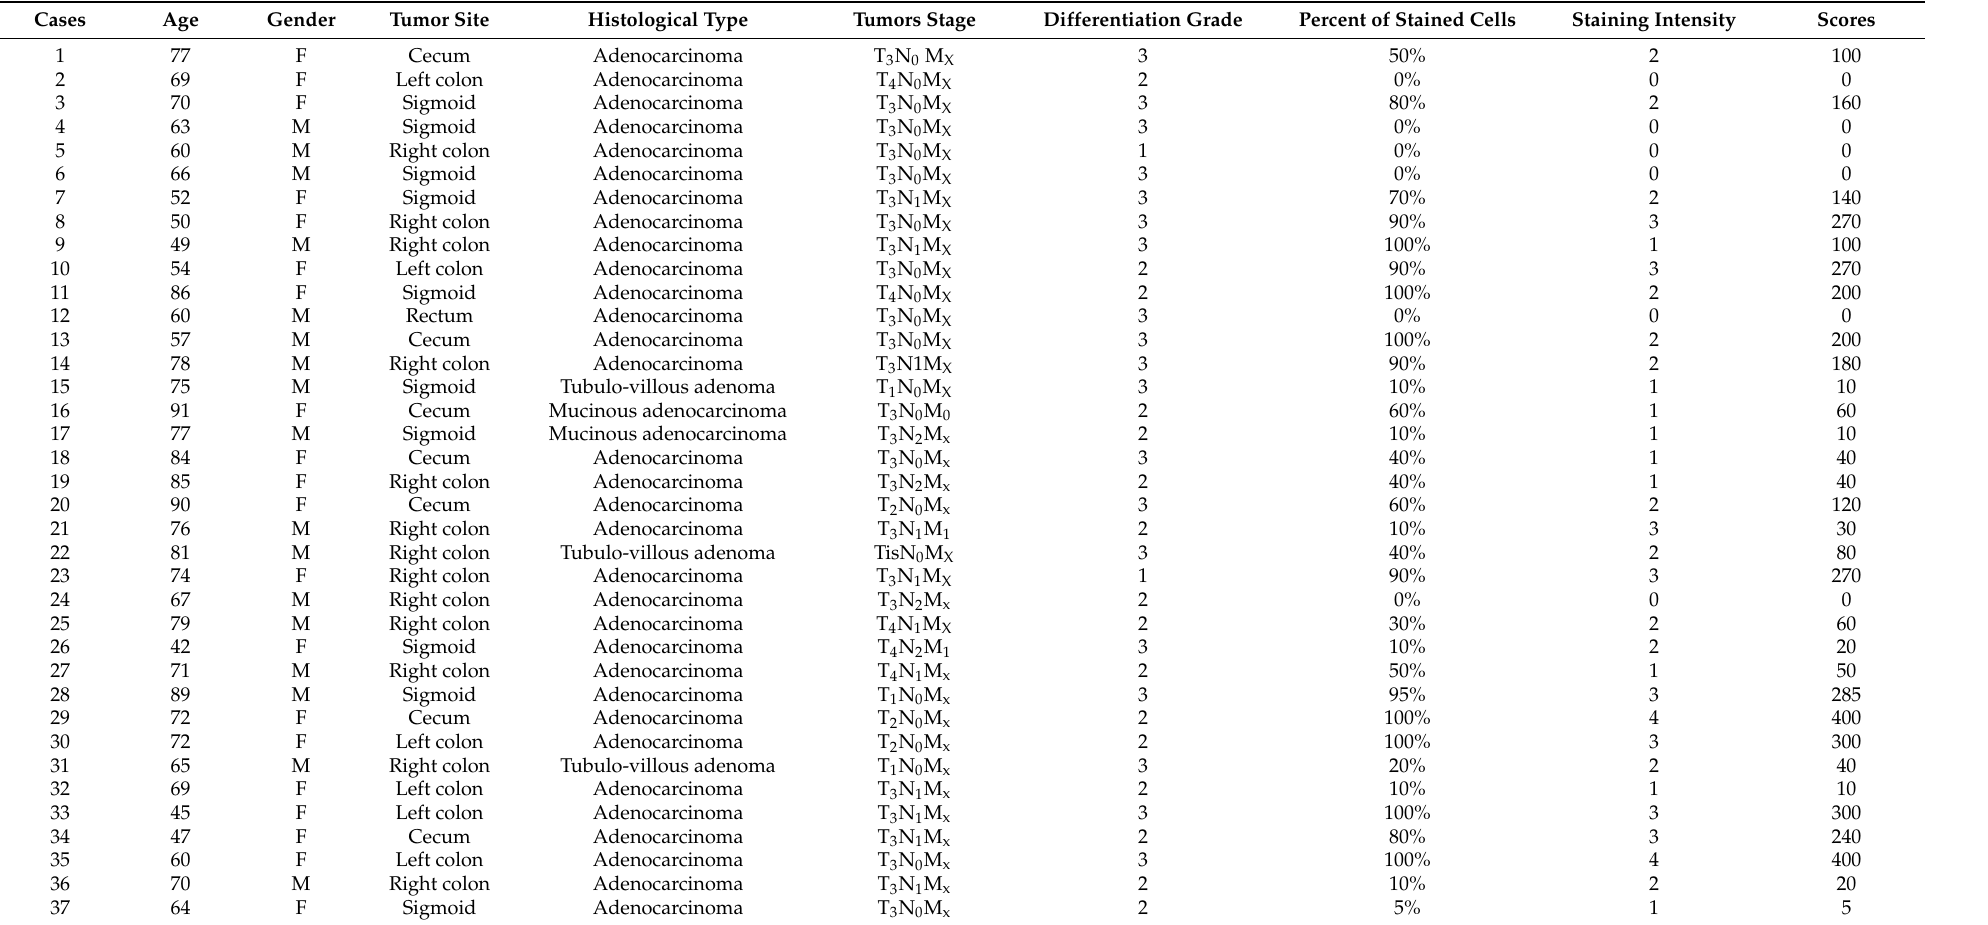
Table 1. Estimation of KLK6 expression in colon carcinoma epithelial